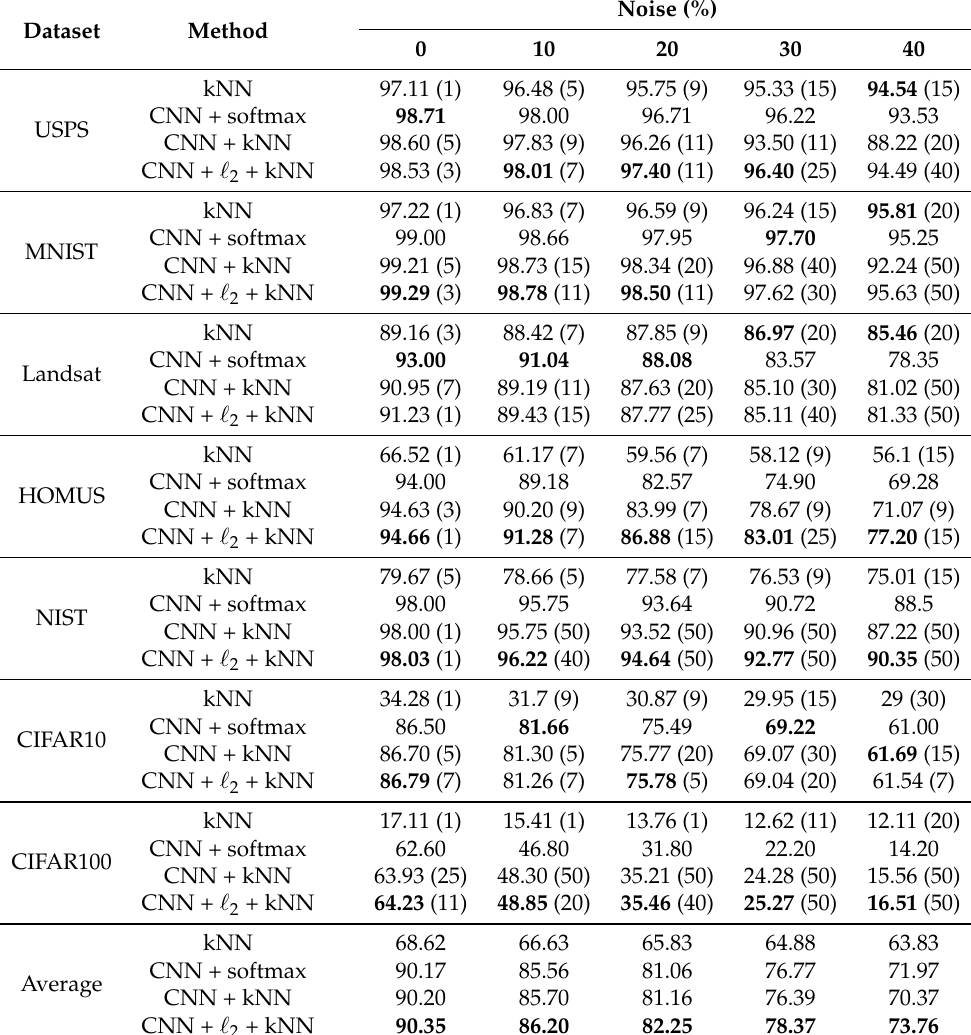
Table 3. F 1 (%) accuracy for each image dataset, classification method and label noise level considered. In the kNN methods, the best value of k is shown between parentheses (unless in the average